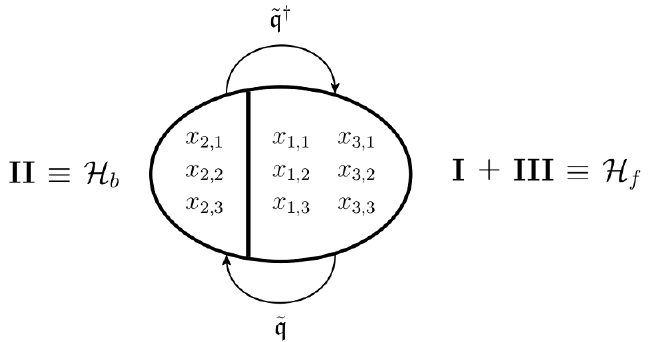
elements. H b and H f again denote 1